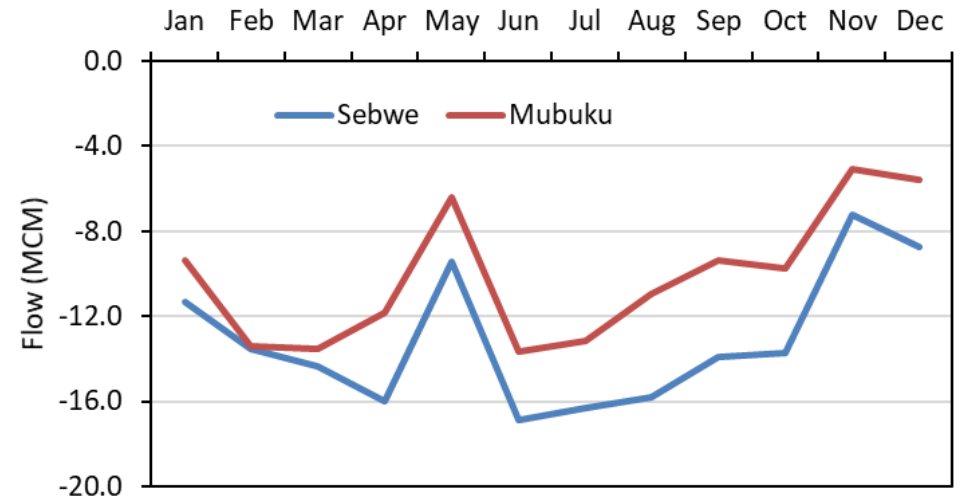
Figure 7. Projected change in water availability in Sebwe and Mubuku sub catchments between 2015 and 2040.